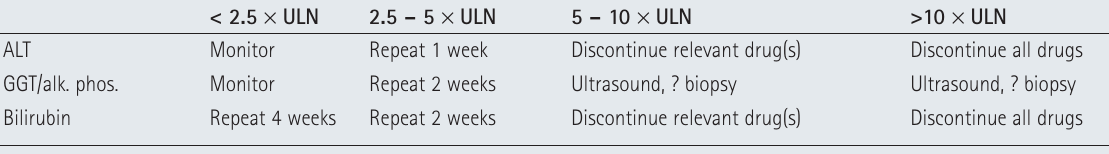
TABLE X. GUIDELINES FOR MANAGING HEPATOTOXICITY